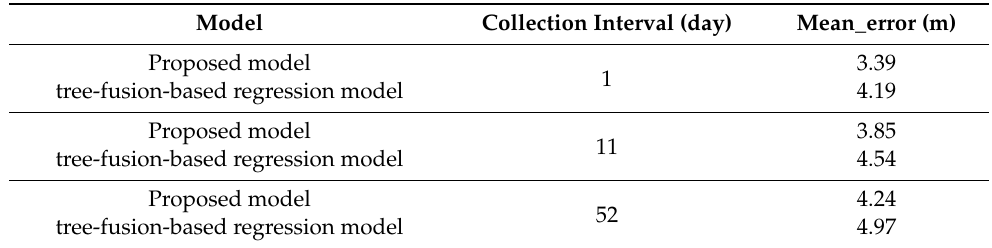
Table 6. Comparison of average positioning errors between the proposed algorithm and the tree-fusion-based regression model.